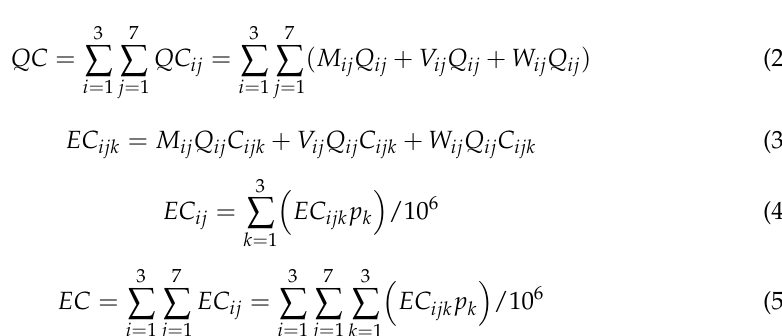
Table 7. CEF and GWP at different energy consumptions.